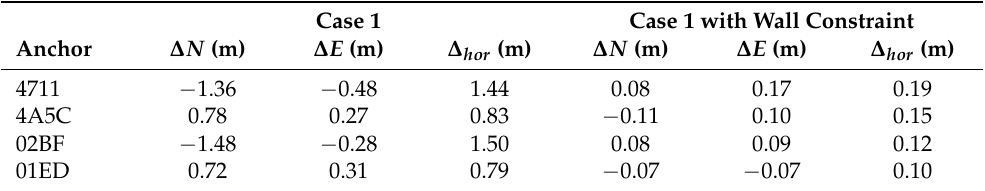
Table 5. Case 1: error of the anchor position estimation based on Test 5.